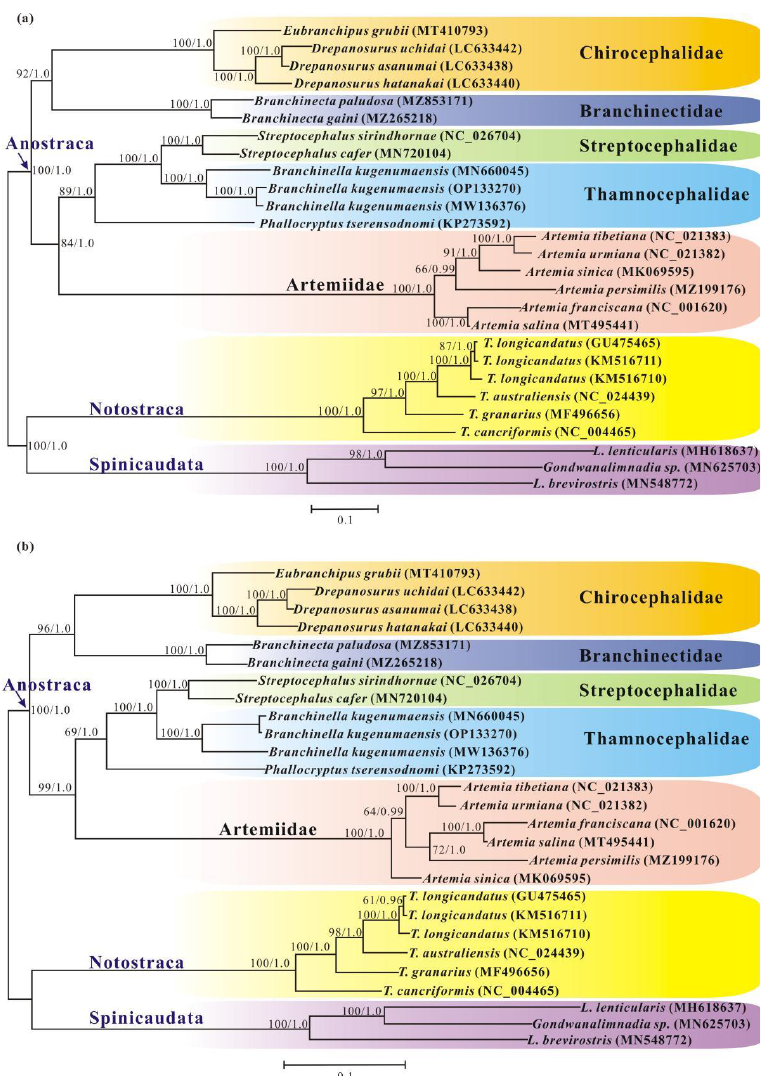
Figure 5. Phylogenetic trees showing relationships among Anostraca based on BI and ML of the mitochondrial nucleotide ( a ) and amino acid datasets ( b ). Bootstrap support values/Bayesian posterior probabilities are shown at the nodes.